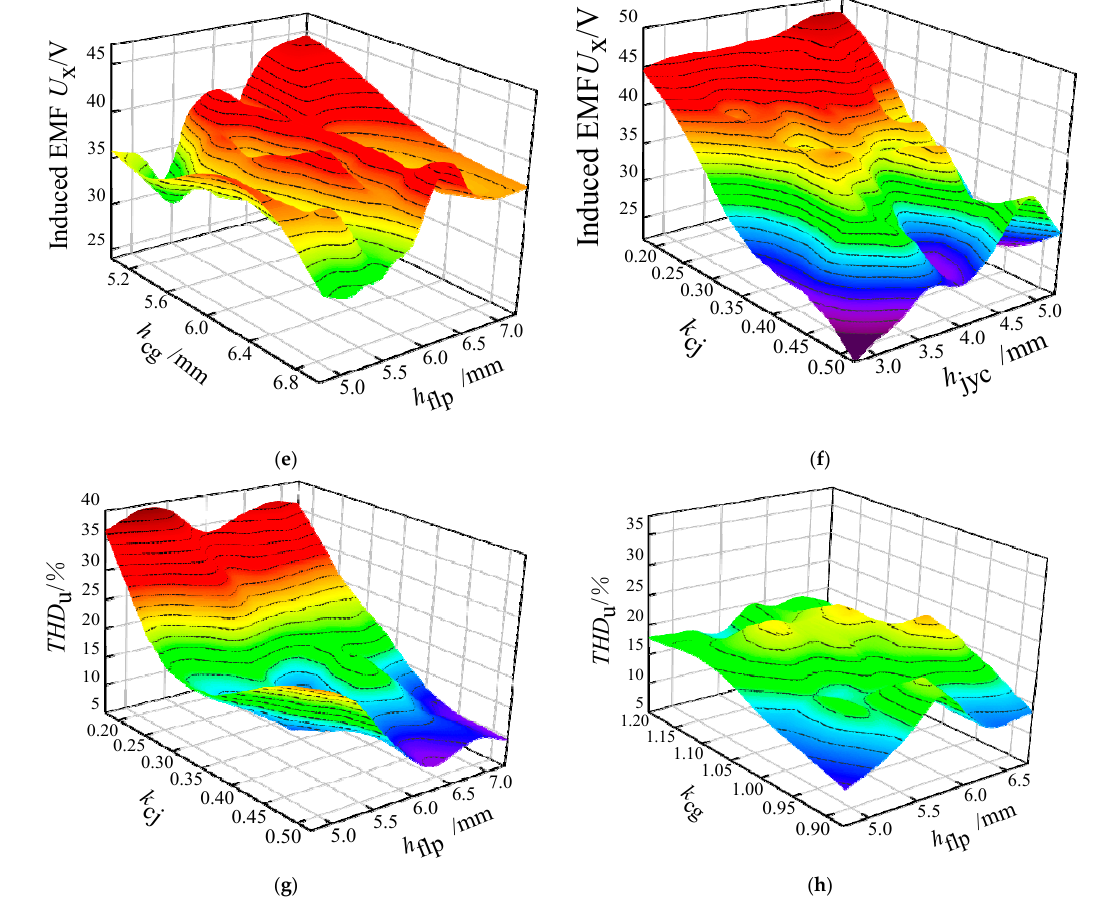
Figure 11. Design variable and response value fitting diagram (partial). ( a ) k cj , h flp , and U x ; ( b ) k cg , h flp , and U x ; ( c ) k cj , k cg , and U x ; ( d ) h cj , h cg , and U x ; ( e ) h cg , h flp , and U x ; ( f ) k c j, h jyc , and U x ; ( g ) k cj , h flg , and THD u ; ( h ) k cg , h flp , and THD u .